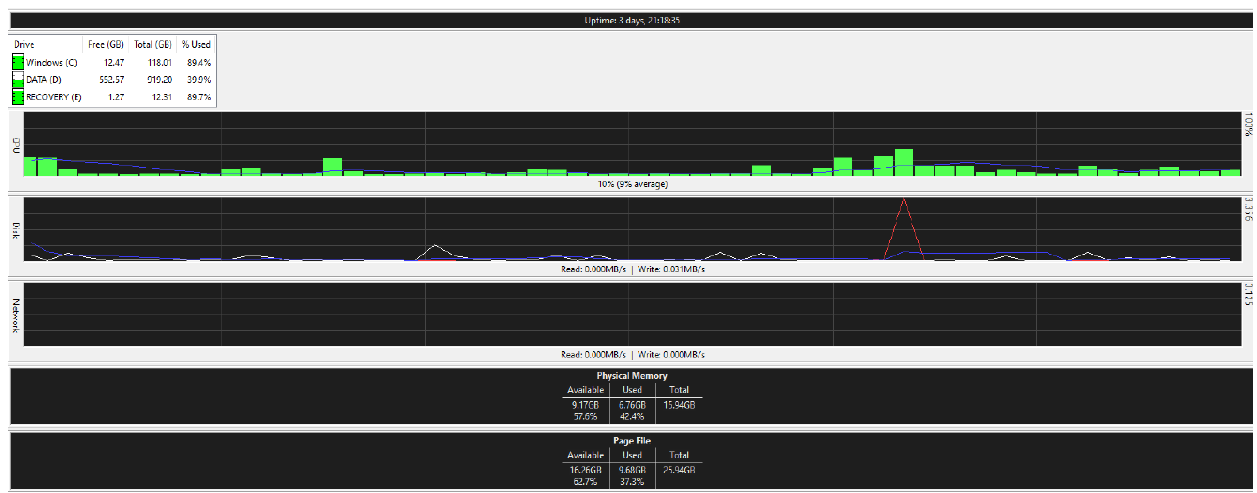
Figure 27. Running the monitoring tool before the application is in process (regular node).